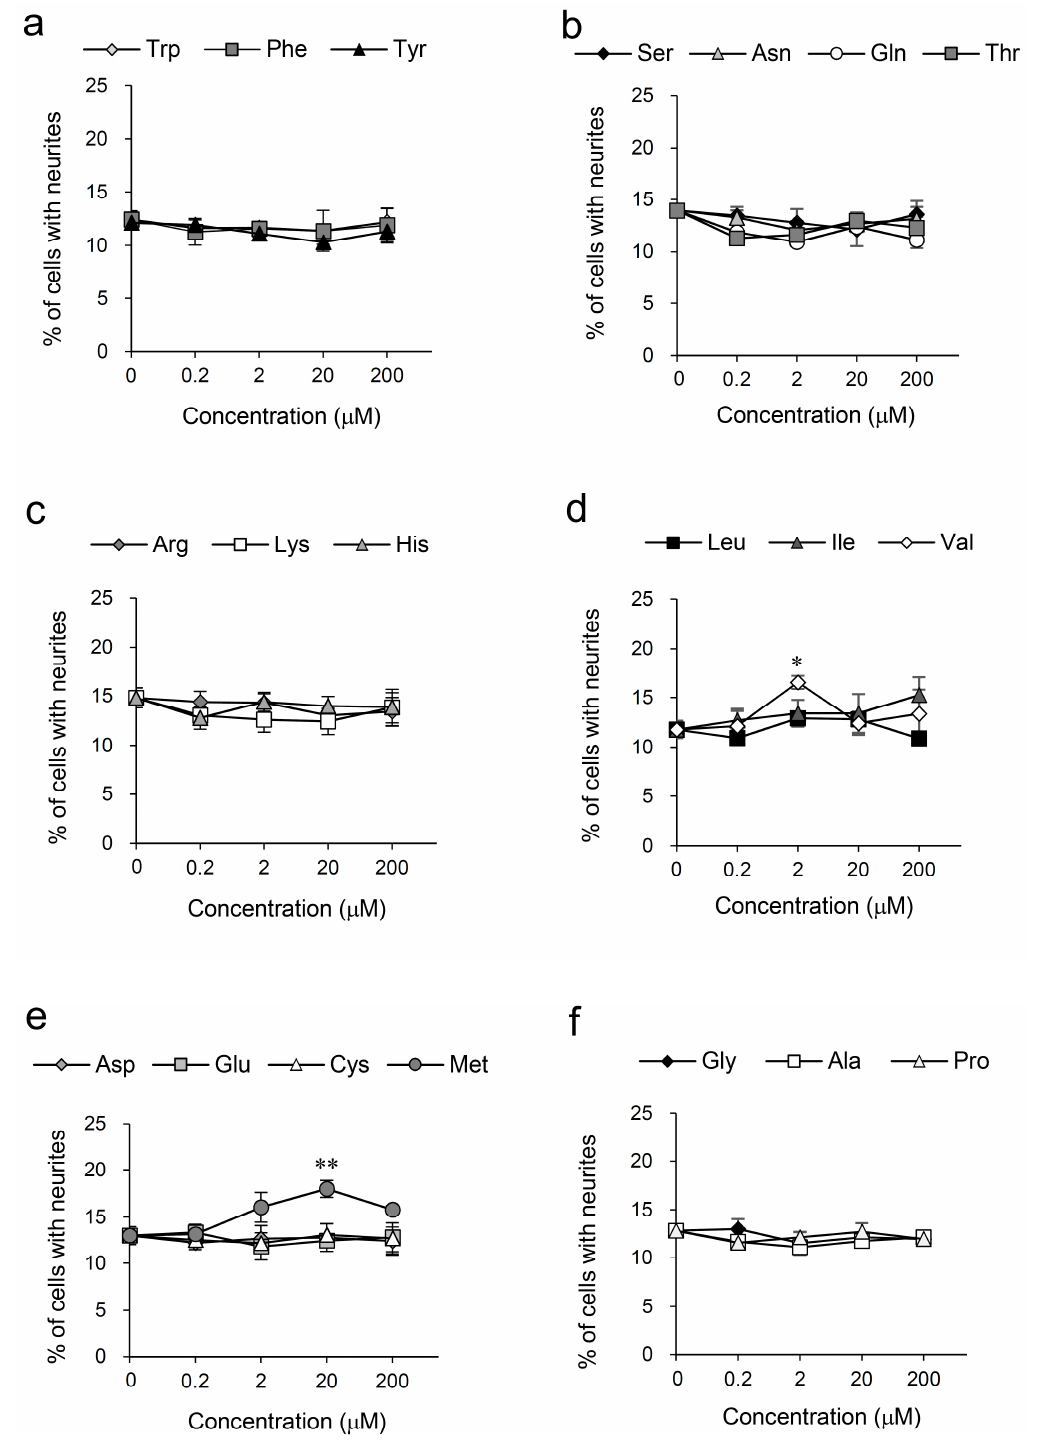
Figure 2. Neurite outgrowth-promoting activities of 20 kinds of amino acids in the presence of Bt 2 cAMP in PC12 cells. Promoting activities of Trp, Phe, and Tyr ( a ), Ser, Asn, Gln, and Thr ( b ), Arg, Lys, and His ( c ), Leu, Ile, and Val ( d ), Asp, Glu, Cys, and Met ( e ), and Gly, Ala, and Pro ( f ) for neurite formation induced by Bt 2 cAMP in PC12 cells. PC12 cells were plated at 4.0 × 10 3 cells/well and cultured with the amino acids at 0.2–200 µ M in the presence of 0.5 mM of Bt 2 cAMP. The extent of neurite outgrowth was measured at 24 h and is expressed as the mean percentage of 300–400 cells. The data represent means ± standard deviation (SD) from three independent experiments. * p < 0.05, ** p < 0.01 (Dunnett’s test), as compared with the control (0.5 mM Bt 2 cAMP only).